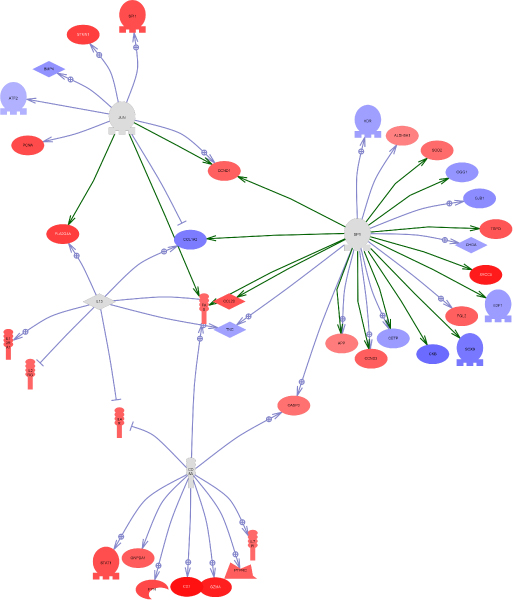
Combined pathway from the Sub Network Enrichment Analysis of Pathway Studio (primary or secondary response effect). Molecules are identified with their HUGO symbol. Red colour shows up regulated genes in the PM8 (primary response) condition versus MM8 (secondary response). Blue colour shows down regulated genes in the PM8 (primary response) condition versus MM8 (secondary response).